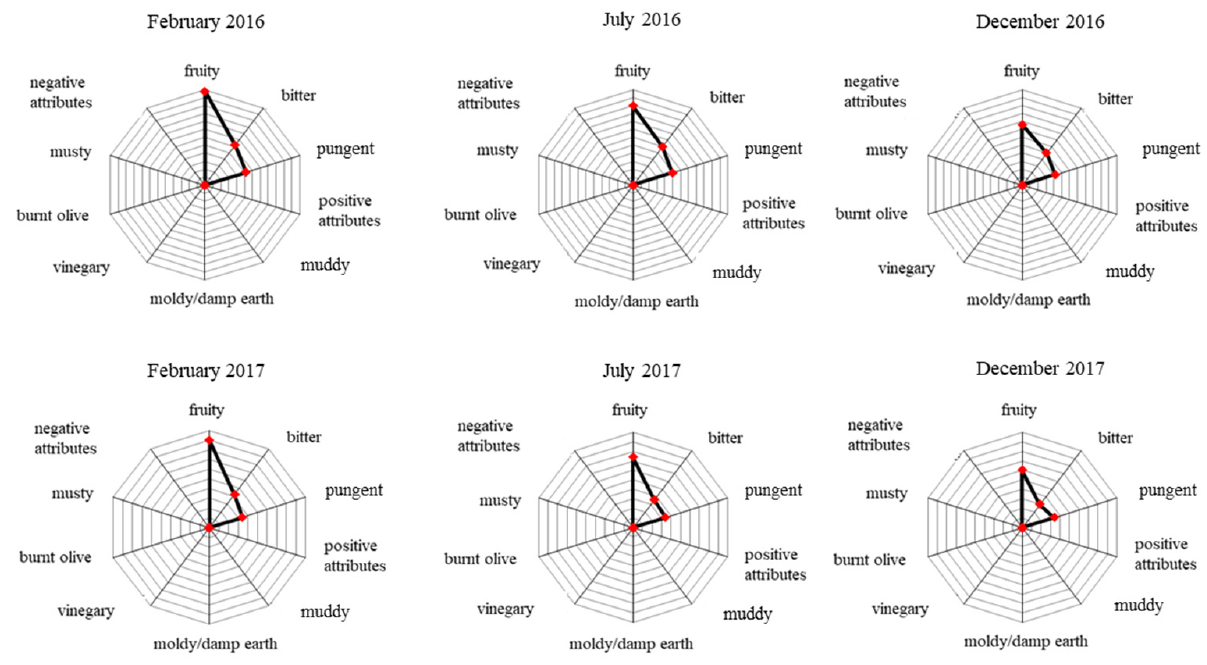
Figure 2. The sensory profiles of the olive oils at different seasons.